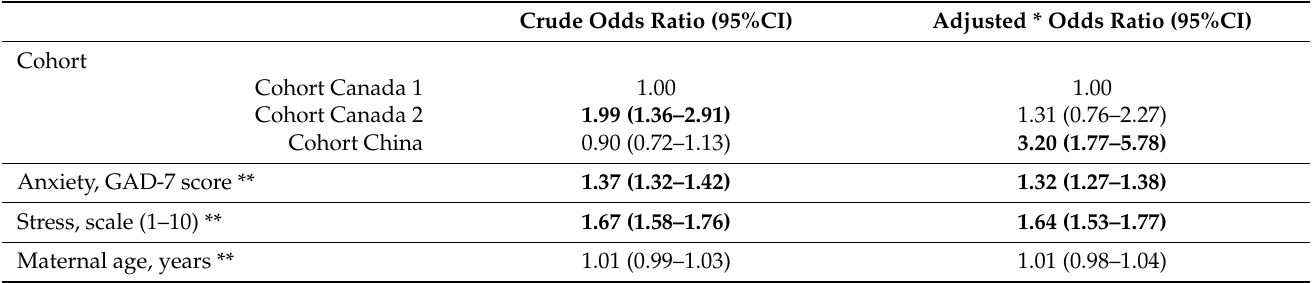
Table 4. Predictors of maternal depression as defined by the Edinburgh Postnatal Depression